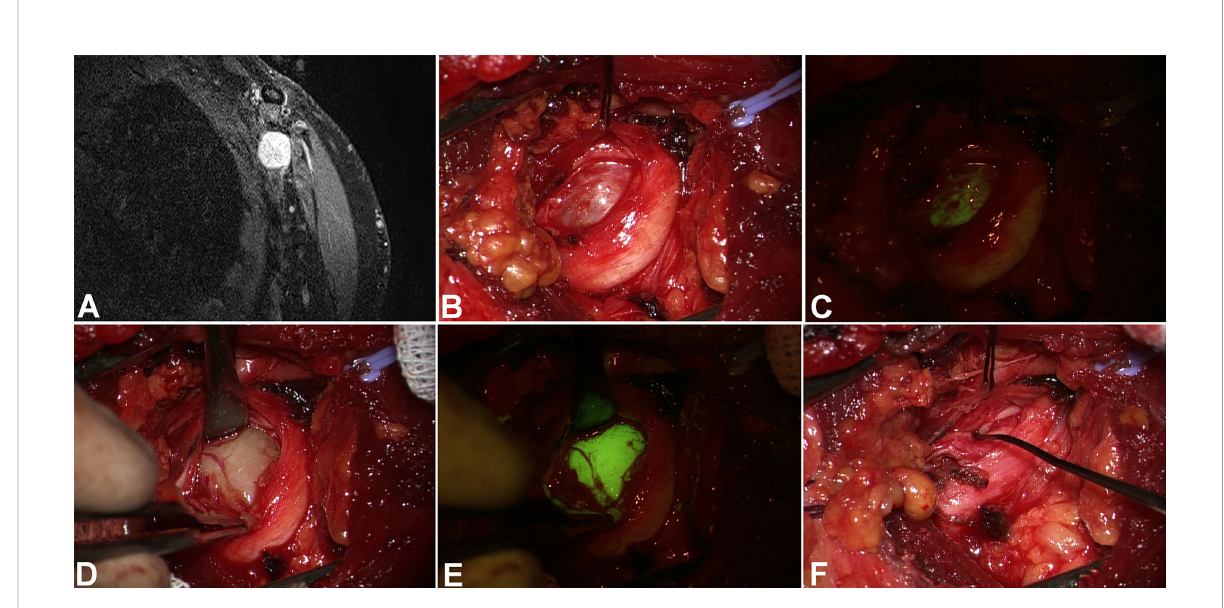
FIGURE 1 Left brachial plexus schwannoma (coronal MRI scan in A ). After skin incision and subcutaneous tissues dissection, the tumor appeared surrounded by the nerve (B) . The fi rst examination under YELLOW 560 fi lter (C) showed a slight and diffuse fl uorescence both of the tumor and the nerve covering the tumor. However, after pseudocapsule incision (D) , the tumor showed an intense and homogeneous fl uorescence (E) , whereas the nerve was only slightly fl uorescent. Tumor removal was performed under intraoperative neurophysiological monitoring (F)